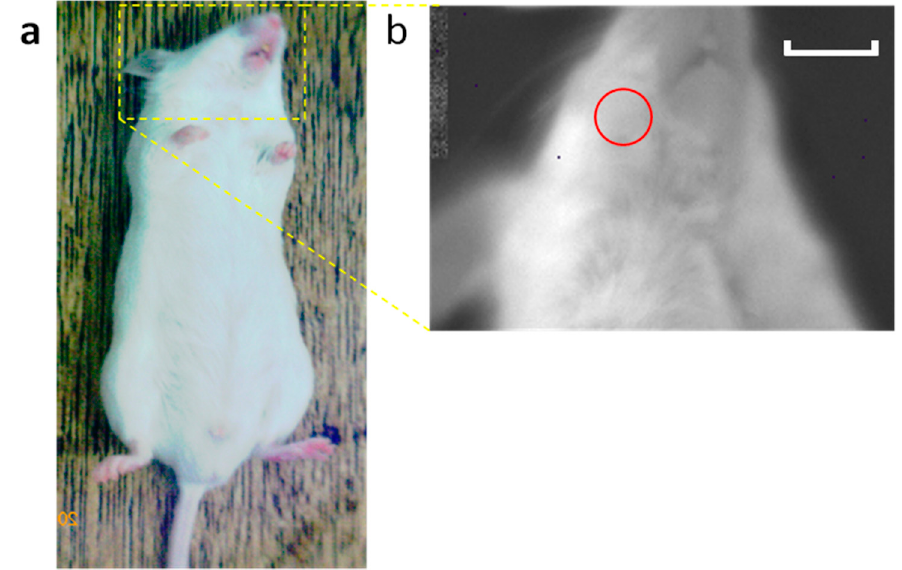
Figure 7. Scheme of bioluminescence imaging. Imaging of the head area was performed ( a ). The red circle shows the region of interest (ROI) ( b ). Luciferase activity was quantified from images displaying surface radiance using circular ROIs. Scale bar = 1